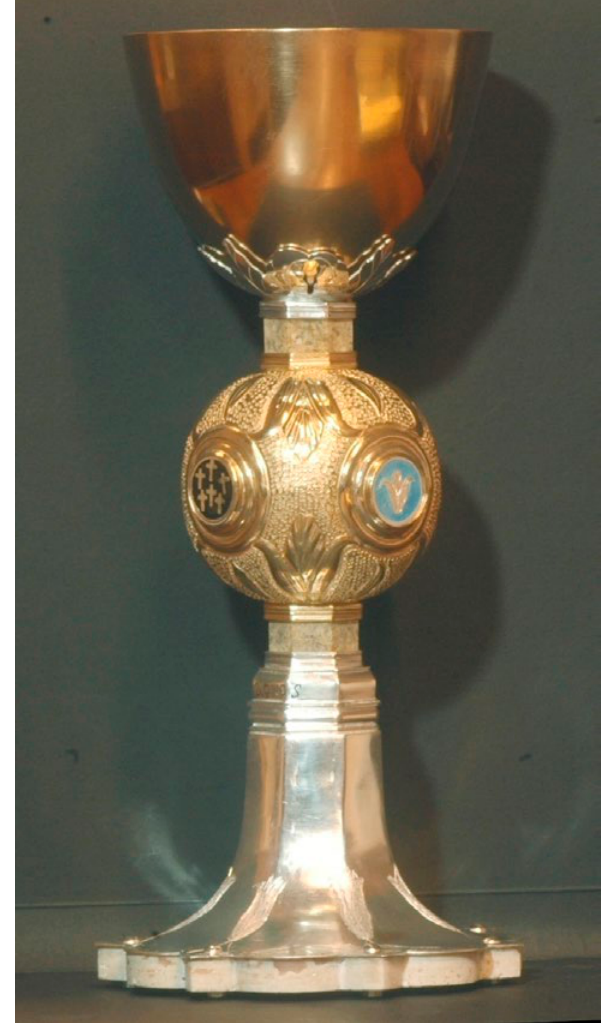
ertine. Technique: lost wax casting, embossing, turning, enamels, niello. Author: Alessandro